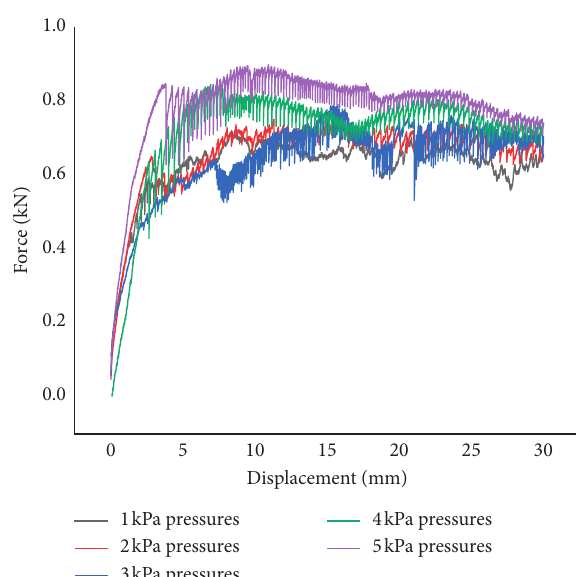
Figure 10: The pullout force-displacement curve with water content of 14% for 30 dry-wet cycles under different overburden